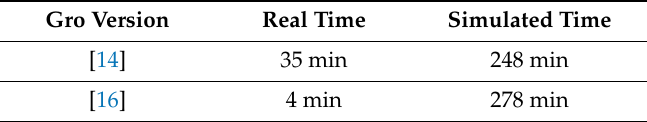
Table 2. Simulation times in the Gro simulator.